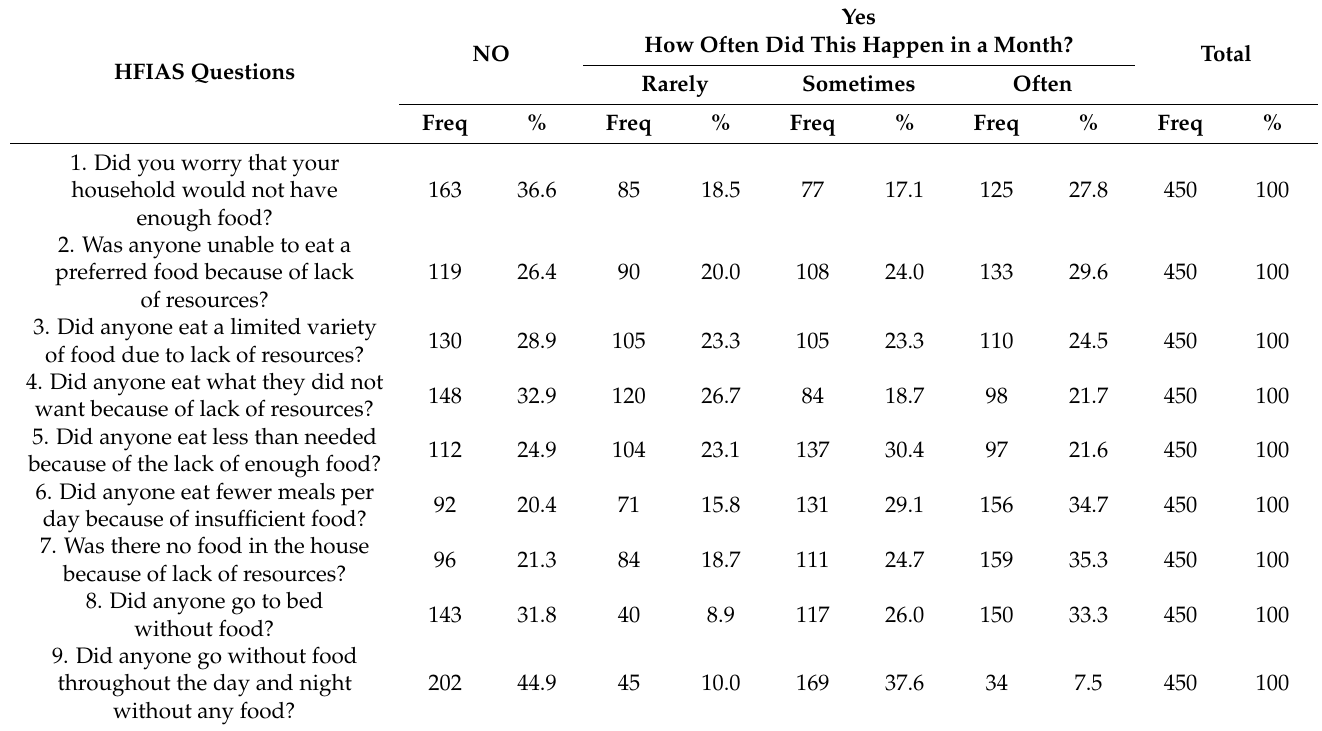
Table 3. Household Food Insecurity Access Score (HFIAS) of the preschool children.